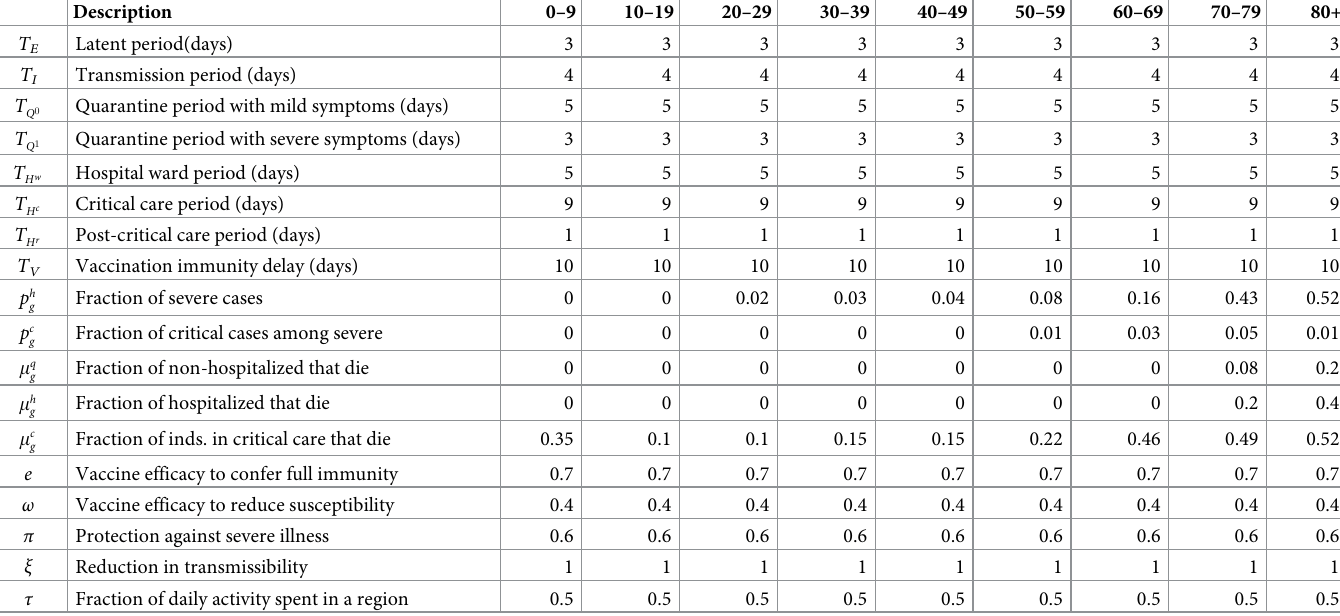
Table 2. Parameters for the epidemic model. The parameters here have been taken from Ref. [12] except for the vaccine efficacy e which depends on several factors including the vaccination type, disease variant, number of doses and time from the vaccination [13–15].Here we set e following Ref. [16].